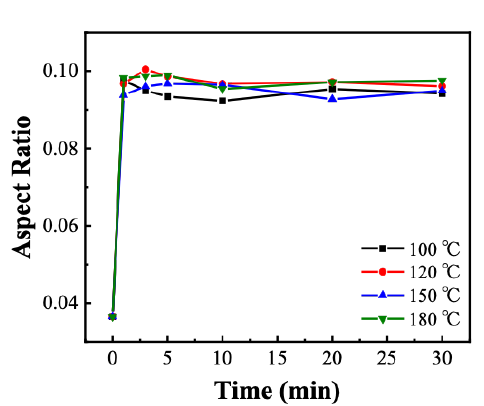
Figure A1. The effect of heating temperature and time in the solvent developing process on the final aspect ratio of the photo-embossed structures.